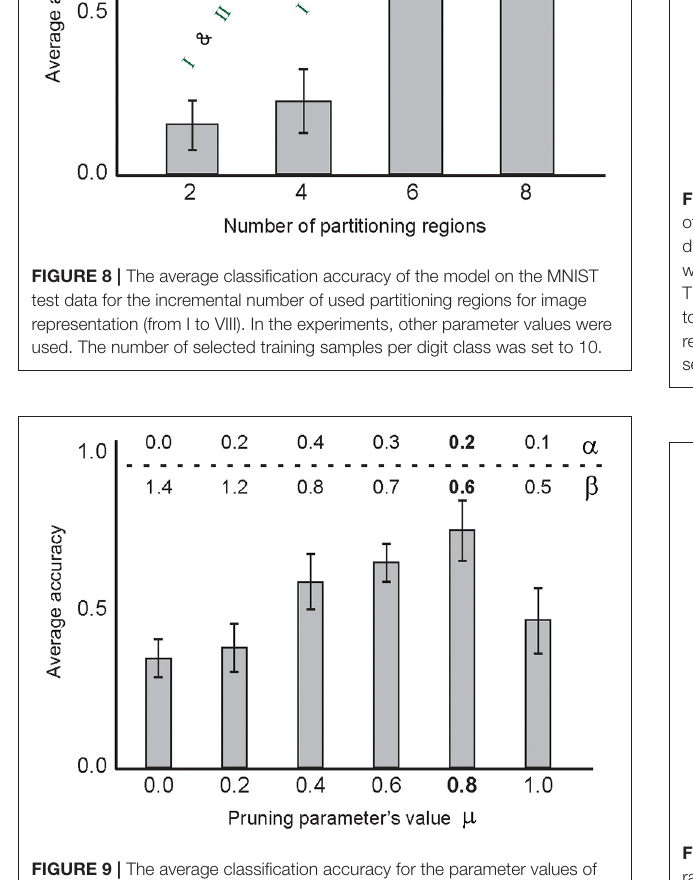
FIGURE 9 | The average classification accuracy for the parameter values of the learning rule ( α , β ) and the synaptic pruning ( µ ) parameter values. Average classification accuracy was measured for different pruning thresholds from 0 to 1 after training the network using 10 selected samples per digit class (using 100 experiments per parameter set) and testing on the entire test set. Different learning parameter values were used for a given pruning threshold. The β values from 0 to 2, and α values from 0 to 1 were evaluated. The results show a maximum classification accuracy for the pruning threshold set to 0.8, α = 0.2 and β = 0.6. All possible combinations of α , β , and µ parameter values were used in the experiments and the best results of the parameter sets are shown. In these experiments, 0.01 was used as the firing threshold of the output neuron and 0.2 was used as the connectivity rate between the second and third layers.